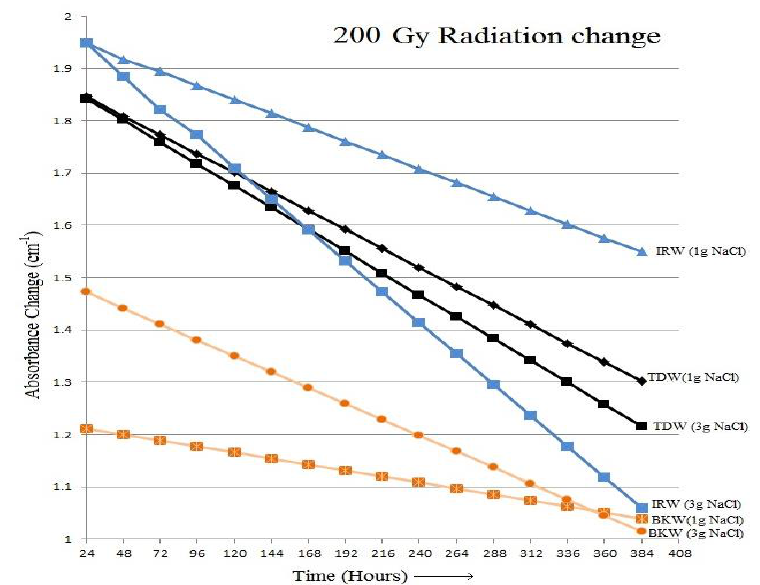
Figure 3: Exposure of dosimeter samples at 100 Gy